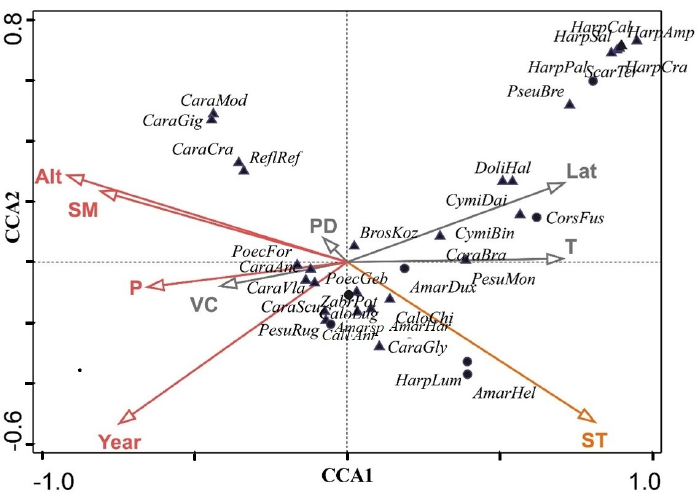
Figure 6. CCA ordination with main gradients marked in red ( ● = herbivores and ▲ = predators, species abbreviations as in Table A2).